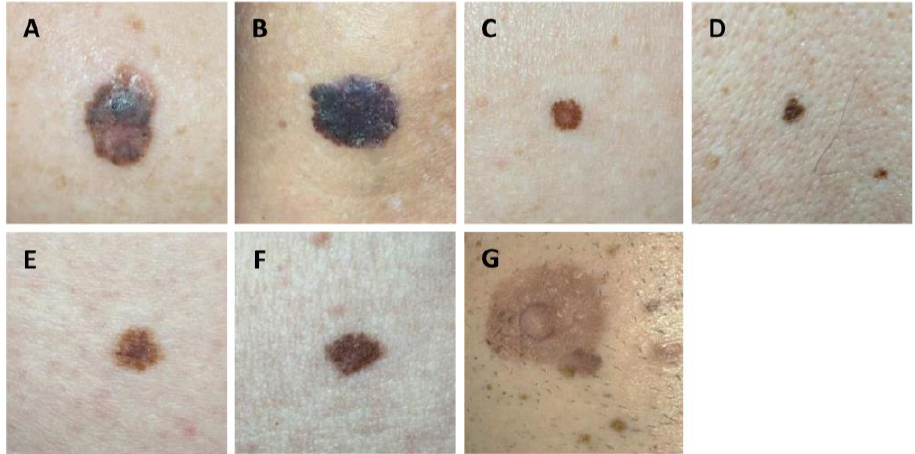
Figure 5. Correctly and falsely classified melanomas by the smartphone app SkinVision ® : ( A , B ). True-positive classified melanoma; ( C , D ). False-positive classified melanoma; ( E , F ). True-negative classified melanoma; ( G ). False-negative classified melanoma.